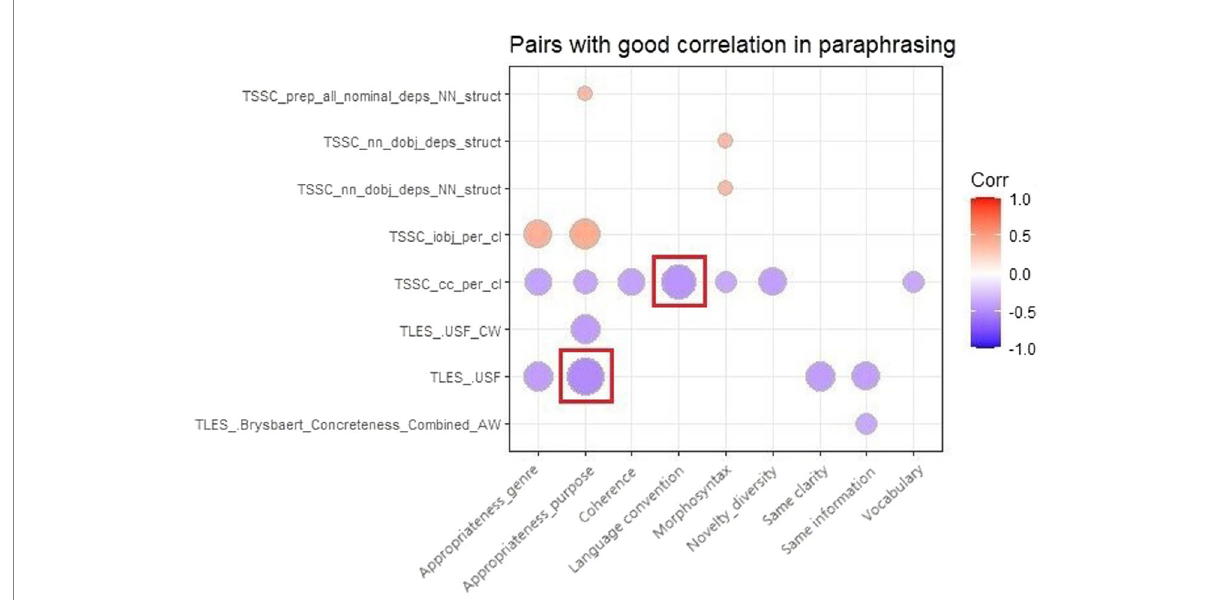
FIGURE 3 Top 18 pairs of NLP indices and translation quality metrics with strongest